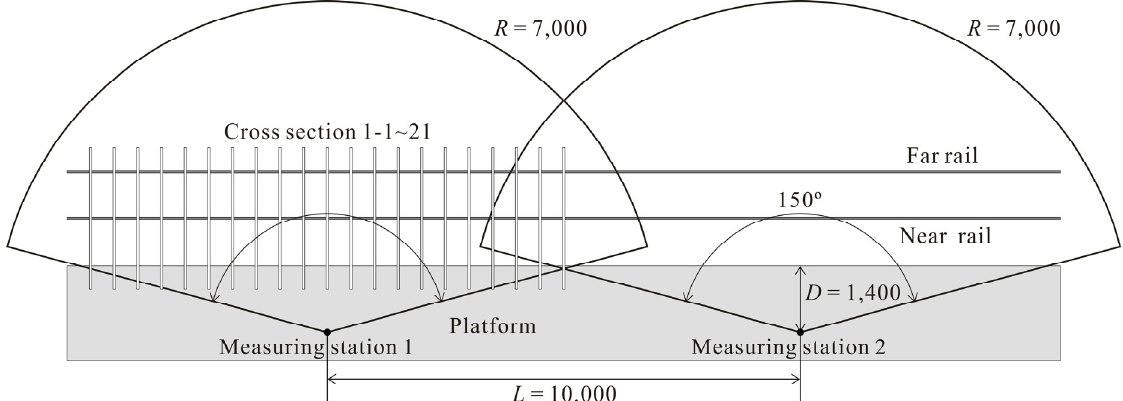
Figure 3. Stop-and-go operation of our new system to measure clearances of a platform (unit: mm)